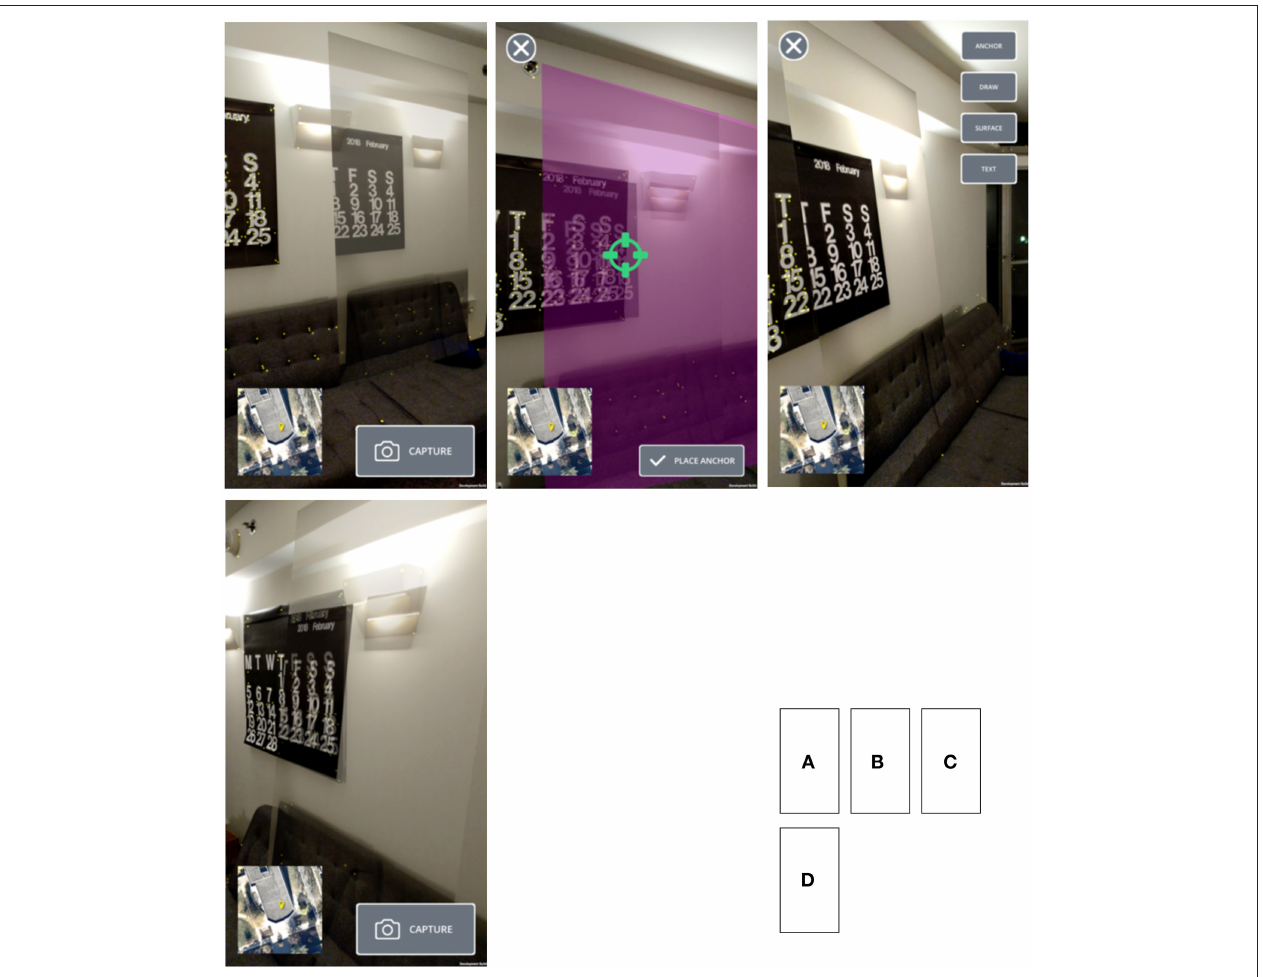
FIGURE 7 | (A) Illustration of image in the AR environment after capture, (B) Image showing the crosshairs turning green indicating there is a spot on the point cloud for this to align to, (C) Image showing alignment of image and AR environment from left angle, (D) Image showing alignment of image and AR environment from right